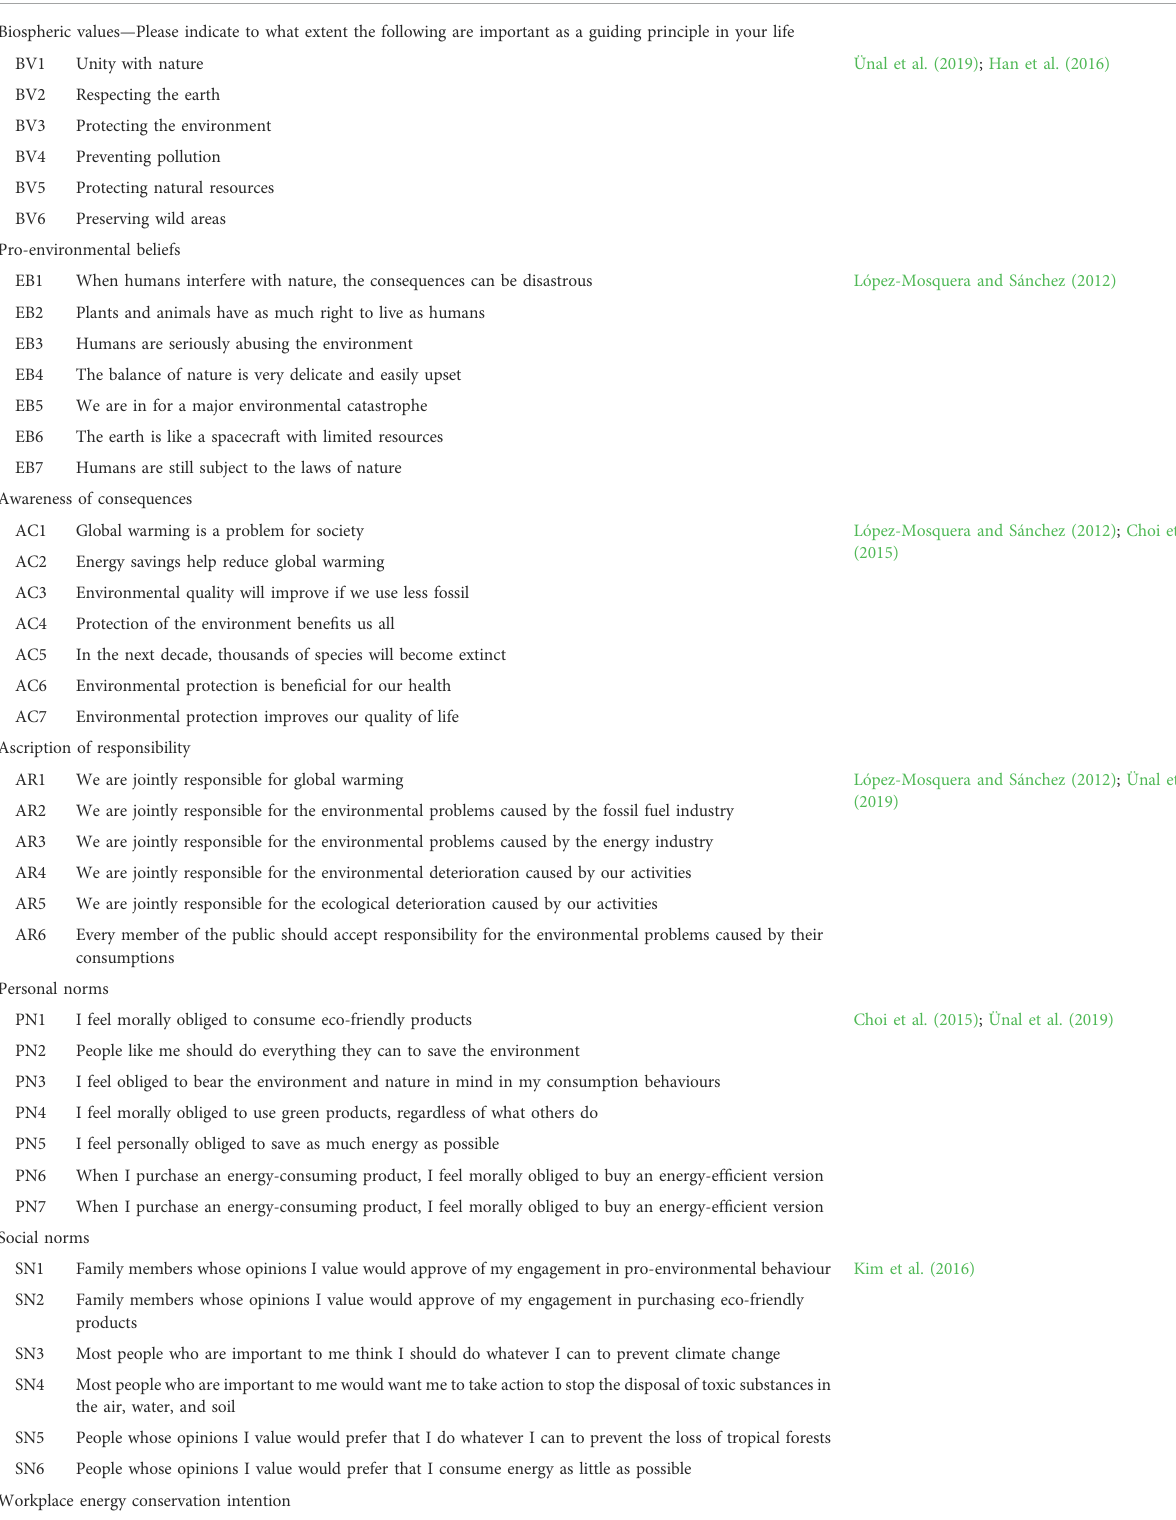
TABLE 1 Survey instrument. Code Items